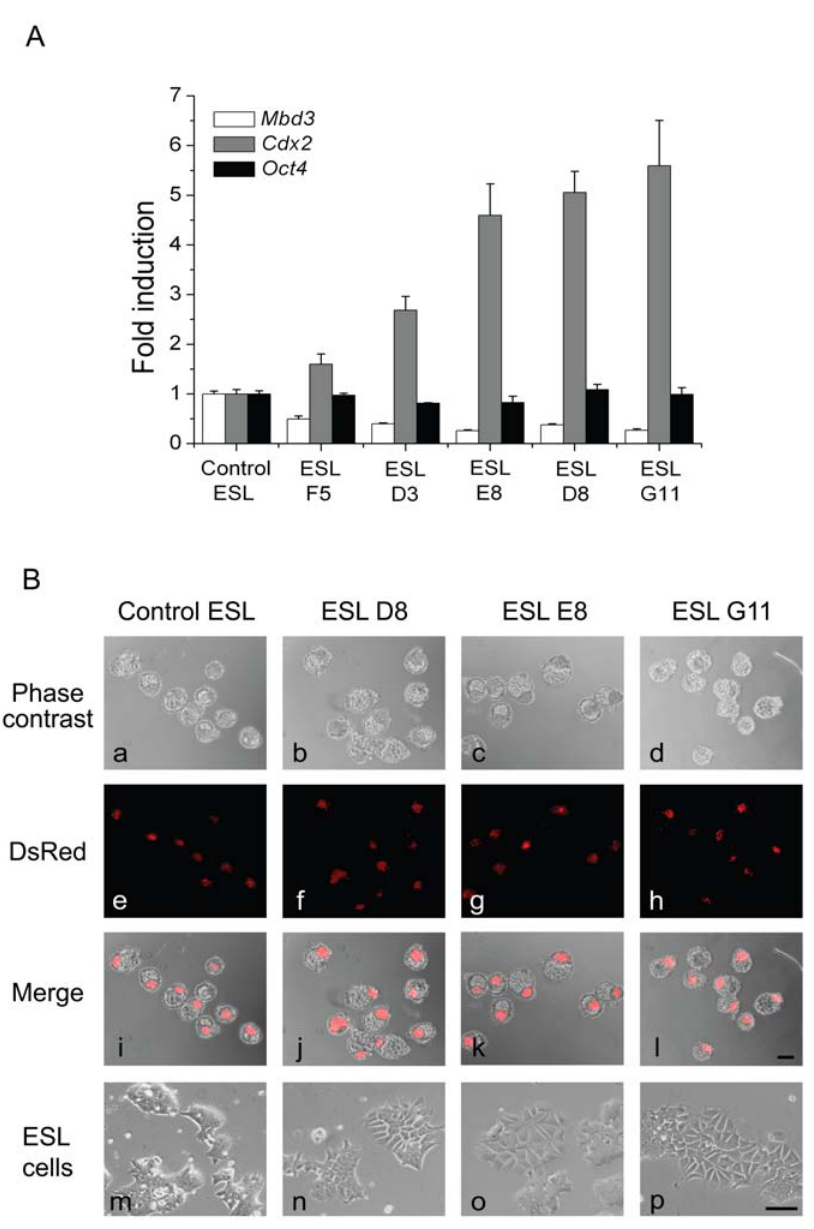
Figure 3. Knockdown Mbd3 is not sufficient for ES cell differentiation. A) Quantitative RT-PCR analysis of Cdx2 and Oct4 in Mbd3 knockdown stable lines. Control ESL represents control siRNA stably transfected mouse ES cells; ESL F5, ESL D3 ESL E8, ESL D8, and ESL G11 represent five independent Mdb3 siRNA stably transfected mouse ES cells. Error bars represent standard deviation from three technical repeats. B) Chimeric analysis of control and three independent siRNA ES cells in wild type mouse embryos. siRNA stably trasnfected cells were aggregated with wild type mouse embryos at the eight-cell stage and cultured to the blastocyst stage (a–l). in vitro morphology of the siRNA ES cells used in aggregations (m–p). Aggregated cells marked by DsRed. Scale bars: l, 200 m m (also applies to a to k); p, 100 m m (also applies to m, n,